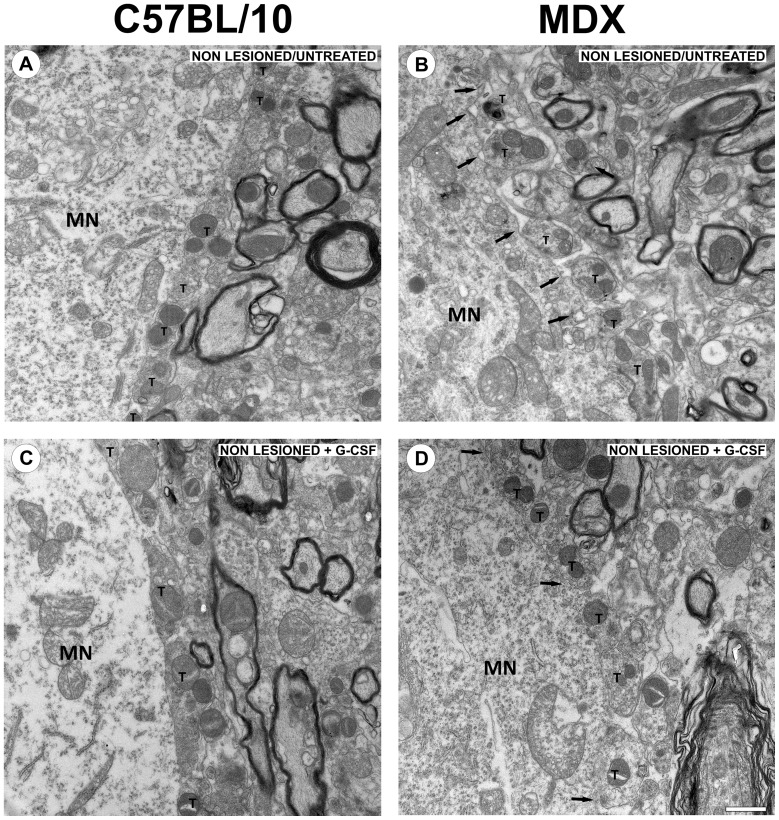
Synaptic covering of non lesioned mice.(A–D) Transmission electron microscopy images. (A) synaptic covering of non lesioned/untreated neuron of the C57BL/10 strain. (B) synaptic covering of non lesioned/untreated neuron of the MDX strain. (C) synaptic covering of non lesioned +G-CSF neuron of the C57BL/10 strain. (D) synaptic covering of non lesioned +G-CSF neuron of the MDX strain. Note some retractions and astrocytic projections (arrows) between the terminals and the membrane of the neuron in Figure B. In all experiments: n = 5. In A–D, magnification, X4800 (scale bar, 1 µm). In B and D, the arrows indicate that the alpha-motoneurons are partially detached, with a reduced area of apposition. In A–D, T indicates the presynaptic terminals and MN indicates the alpha-motoneuron’s cell body.